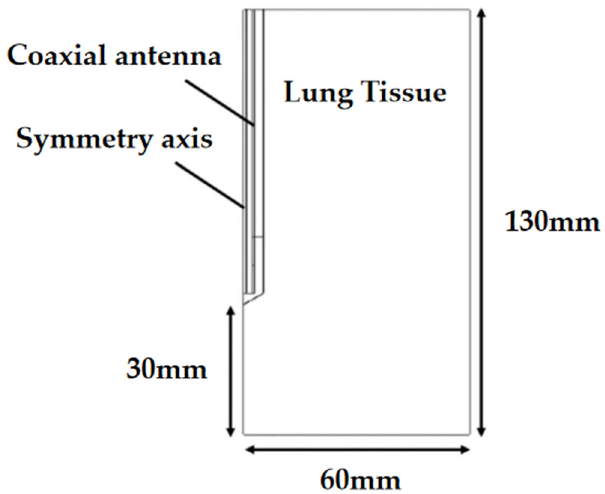
Figure 3. Microwave antenna model.